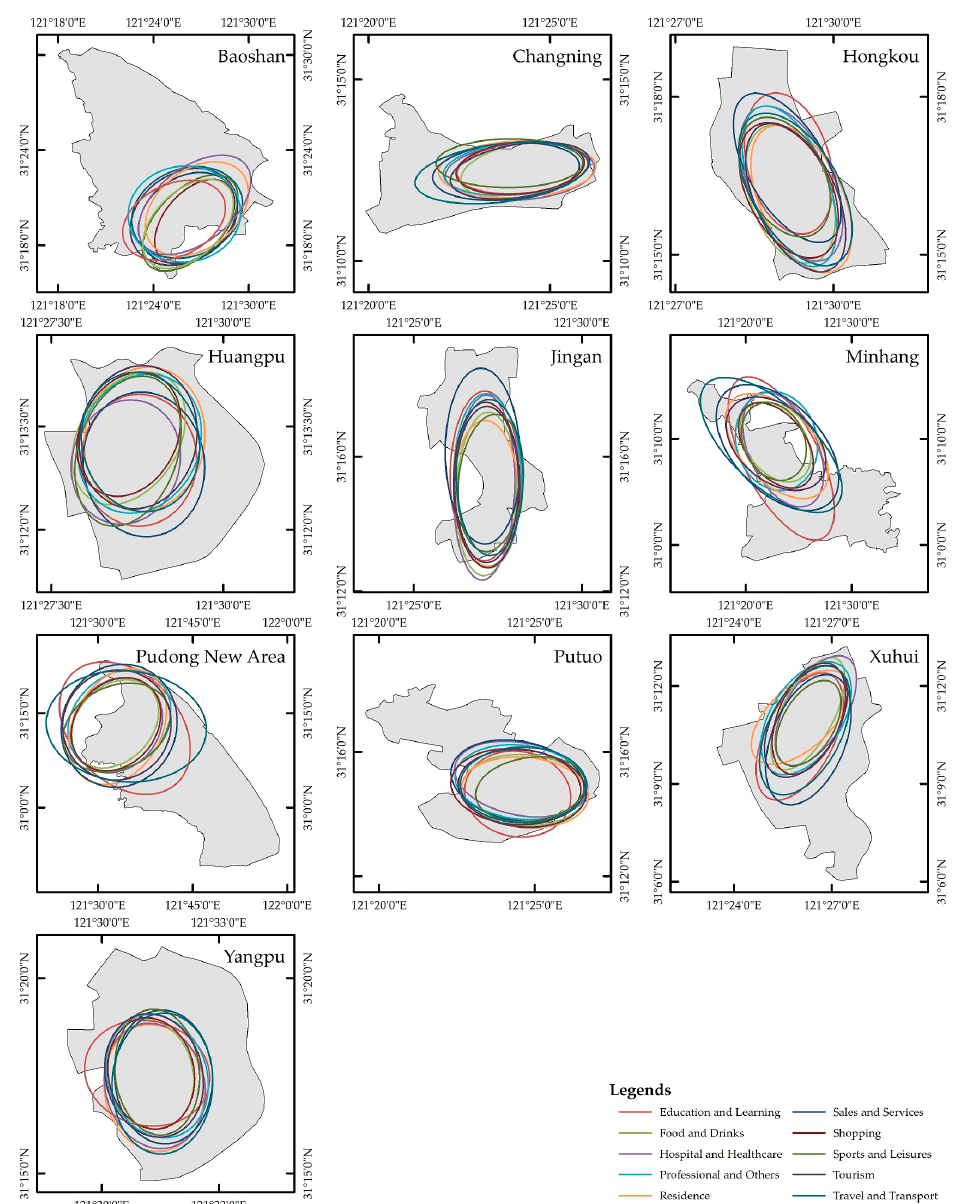
Figure 18. SDEs of activities in districts of Shanghai.